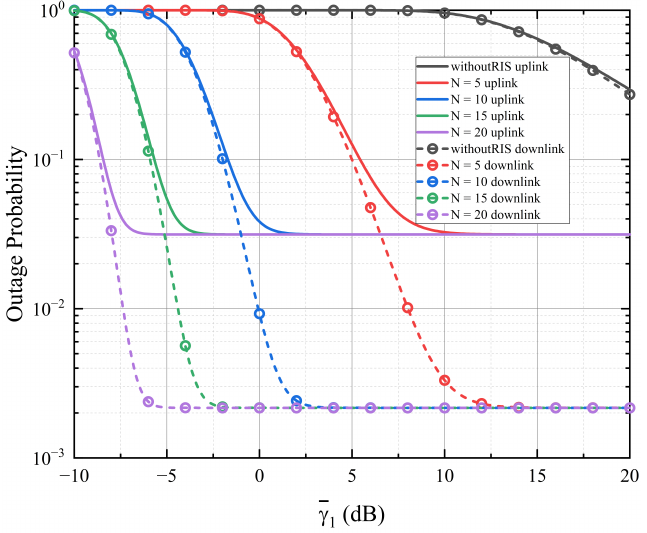
Figure 3. Outage probability with different N when γ th = 15 dB, α = 4.0, β = 1.6, ξ = 10, γ 2 = 50 dB, d = 5.0